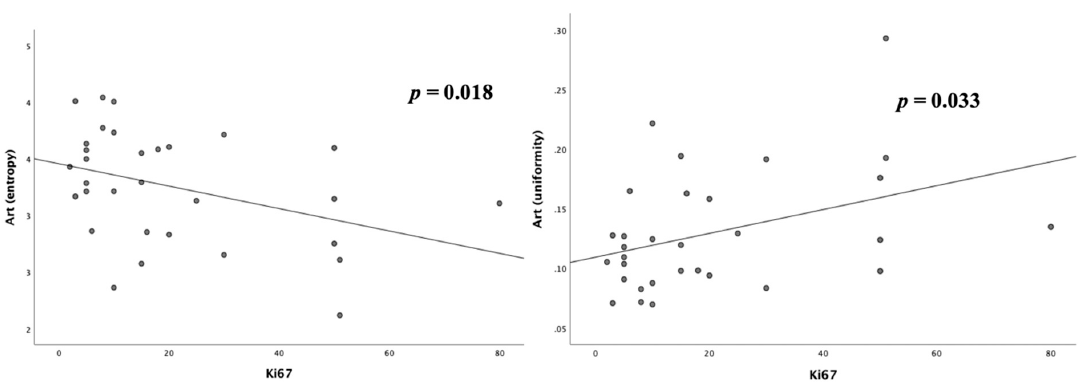
Figure 3. Scatter plots of correlation between Ki67 levels and Art entropy ( left ) and Art uniformity ( right ). Table 3. One-way ANOVA and ROC tests on Art entropy and Art uniformity for the identification of high The Art uniformity cut-off of 0.122 showed 80% sensitivity and 64% specificity in identifying G3 tumor grade.